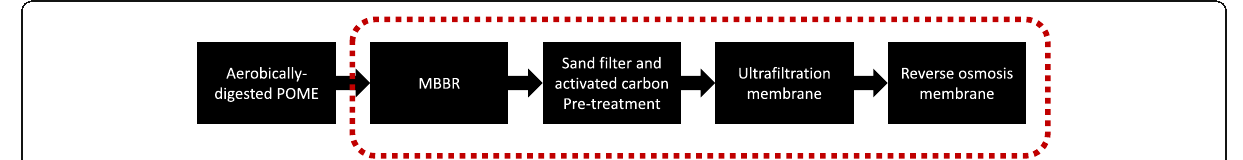
Fig. 1 Process flow of integrated membrane-filtration